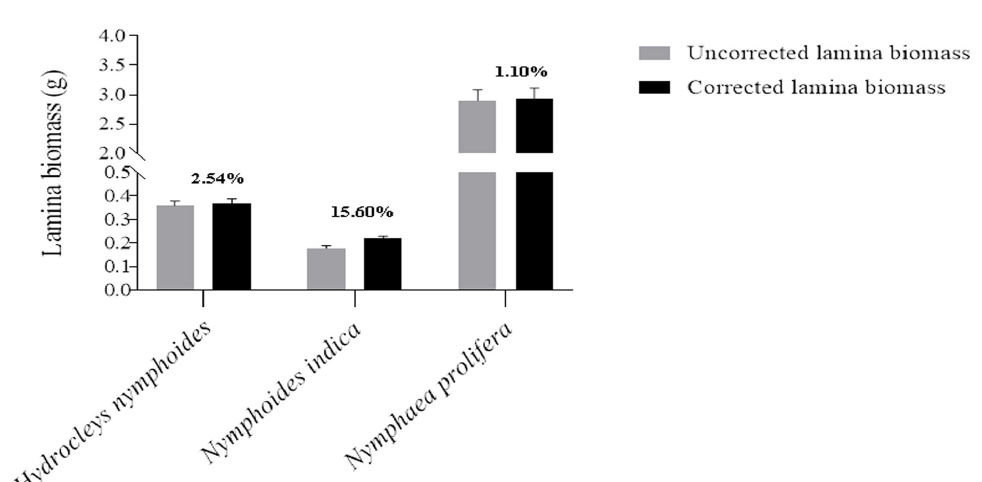
Figure 5 - The uncorrected lamina biomass and the correct lamina biomass per leaf among floating leaf macrophytes species in growth period. The uncorrected lamina biomass is the weight of the lamina measured directly, without including herbivorous damage. The corrected lamina biomass is the weight of the lamina adding herbivorous damage. % indicates biomass removed by herbivory; therefore it indicates underestimation of the leaf lamina biomass in each macrophyte species when the uncorrected lamina biomass is